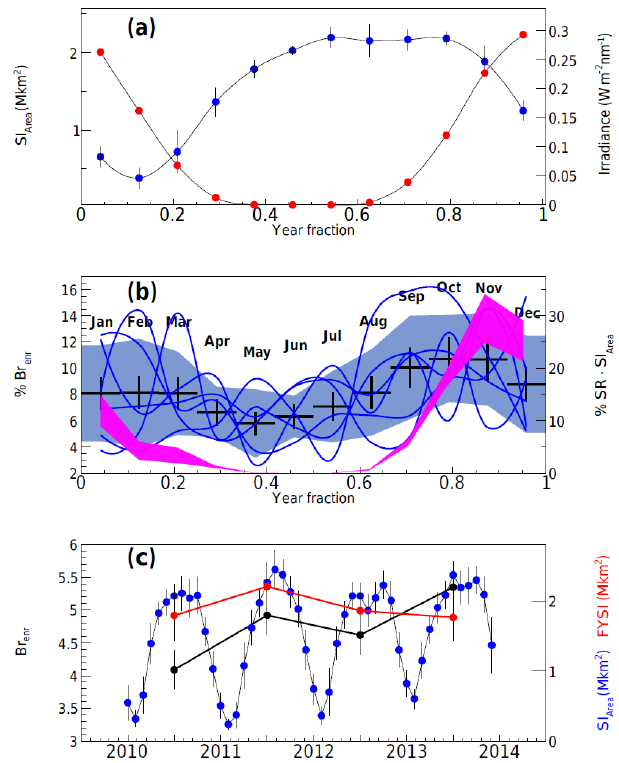
Figure 7. (a) Monthly values of sea ice area (blue) within the 130 ◦ E–170 ◦ W sector from 2010 to 2013 ( ± 1 σ , month variabil- ity) and daily average (24h) total downwelling spectral irradiance (red) calculated using the TUV model at 71 ◦ S, 158 ◦ E. Each irra- diance calculation was set on the 15th day of each month in 2012. (b) Seasonality of annual bromine enrichment along the traverse: the monthly trend shows a seasonal feature with the maximum in spring. Each line refers to a core of the transect ( ± 1 σ , shaded blue area). The month averages are displayed in black. The systematic uncertainties associated with the dating are shown as verticals error bars. The magenta band represents the product distribution of nor- malized sea ice area and insolation expressed in annual percentage. (c) Monthly sea ice area values (blue) from 2010 to 2013 with an- nual values of FYSI (red) and averaged bromine enrichment (black).